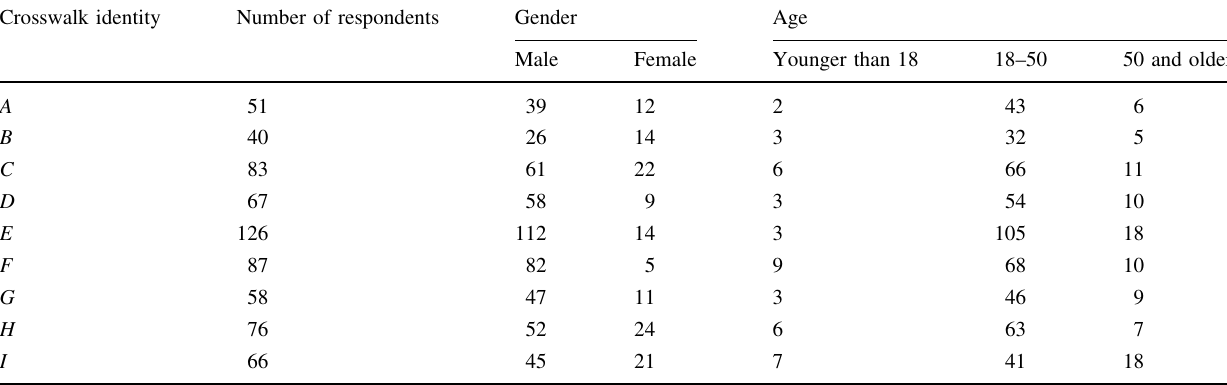
Table 4 Gender and age distribution of each surveys site Crosswalk identity